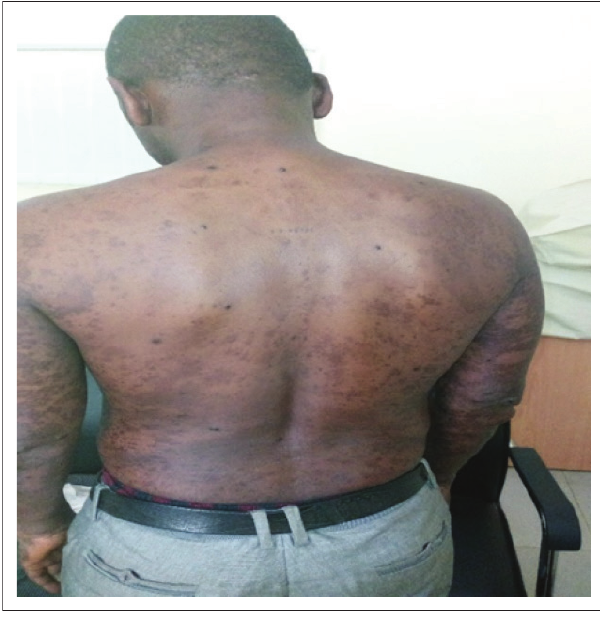
FIGURE 2: Posterior view of the skin lesion diagnosed as Kaposi sarcoma and Molluscum contagiosum.